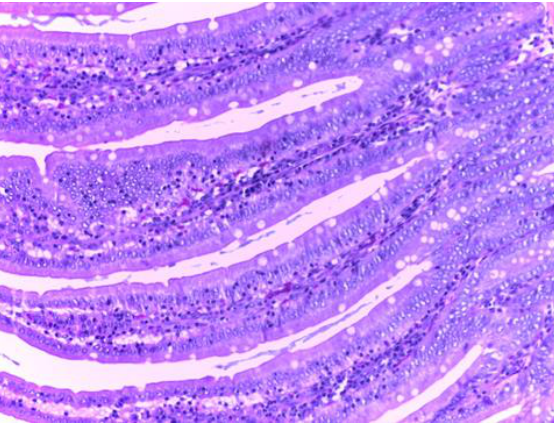
Figure 13. Histological examination of group V (H&E stain, 20X).